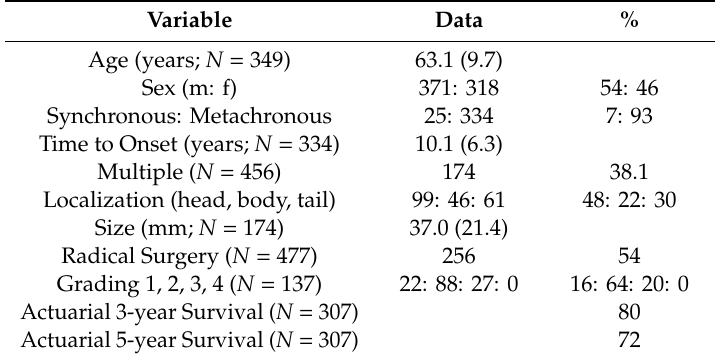
Table1. Analysisof814isolatedpancreaticmetastasesfromrenalcellcarcinoma[24,26–195]; N = number of cases with adequate documentation; (standard deviation of